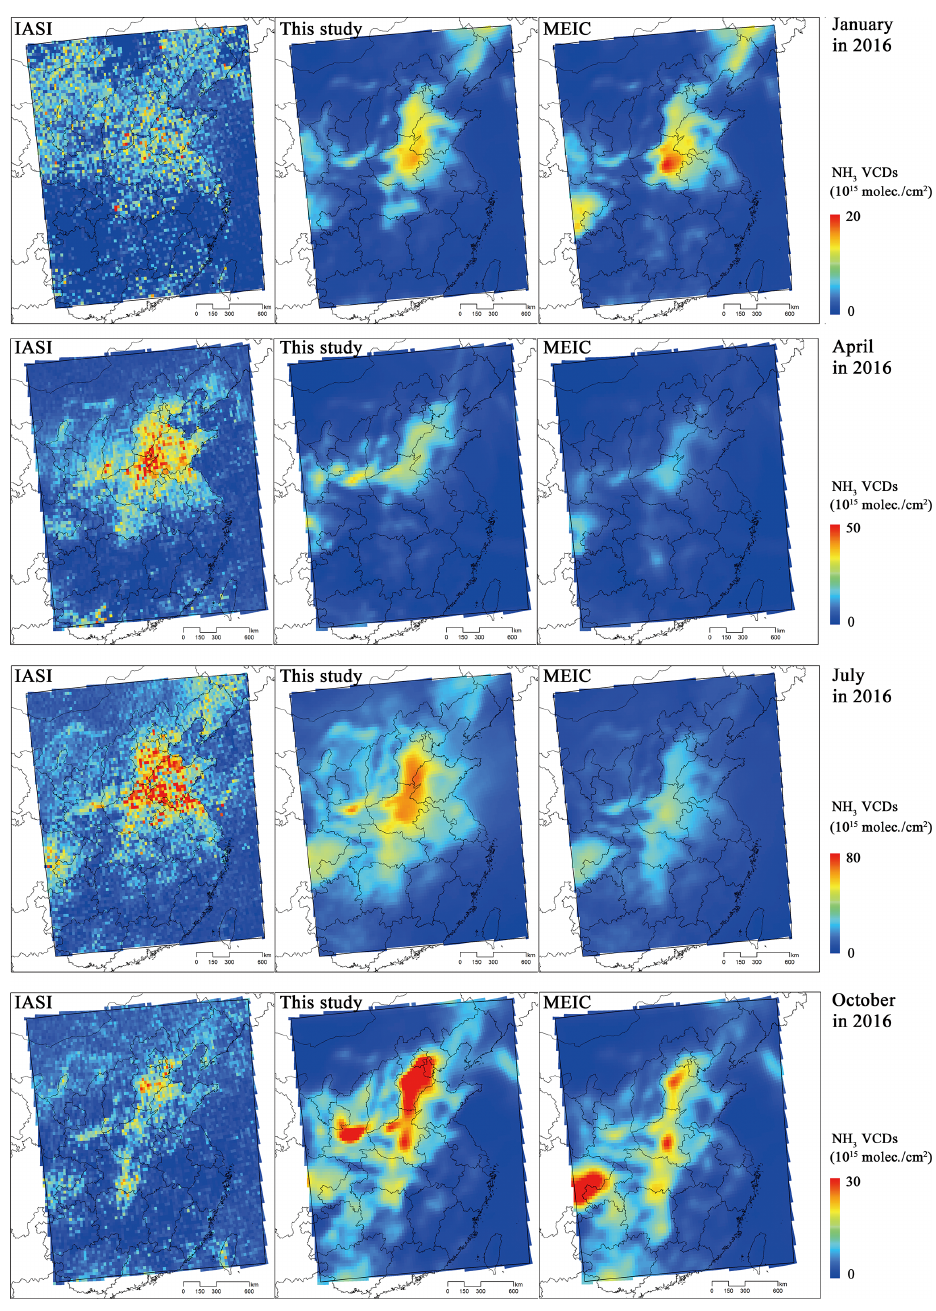
Figure 8. The spatial distribution of IASI NH 3 VCDs and NH 3 VCDs from WRF-Chem based on the two inventories in January, April, July, and October (2016). Different color scales represent different months to indicate the spatial distribution of the NH 3